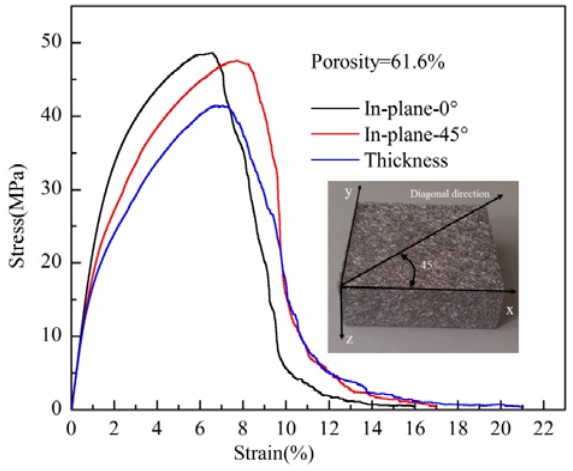
Figure 9. Uniaxial tensile stress-strain curves of the PTWMs in the in-plane and through-thickness direction. Table 3. Summary of the tensile properties of the PTWMs with different sampling direction. Porosity after Sampling Ultimate Tensile Elongation at Sintering Parameters Sintering (%) Direction strength (MPa) F-max